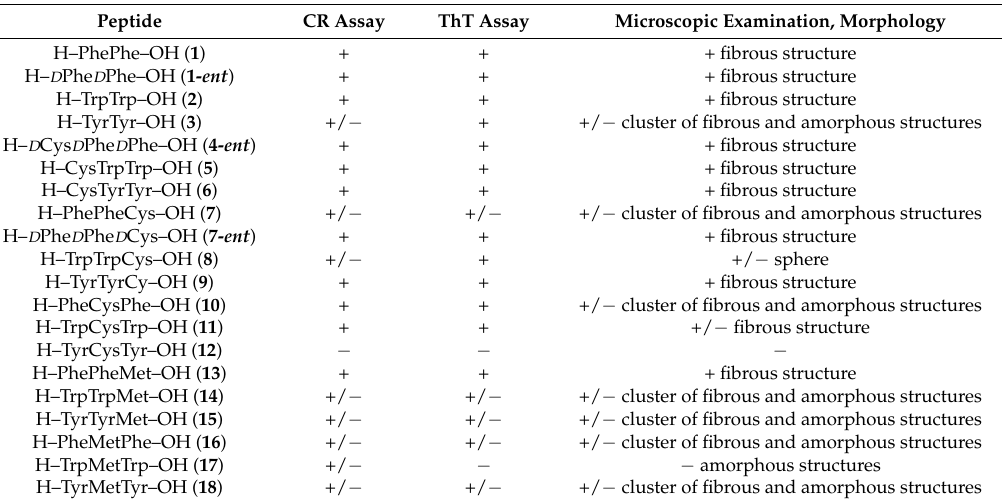
Table 1. Results of susceptibility to aggregation of peptides 1 – 18